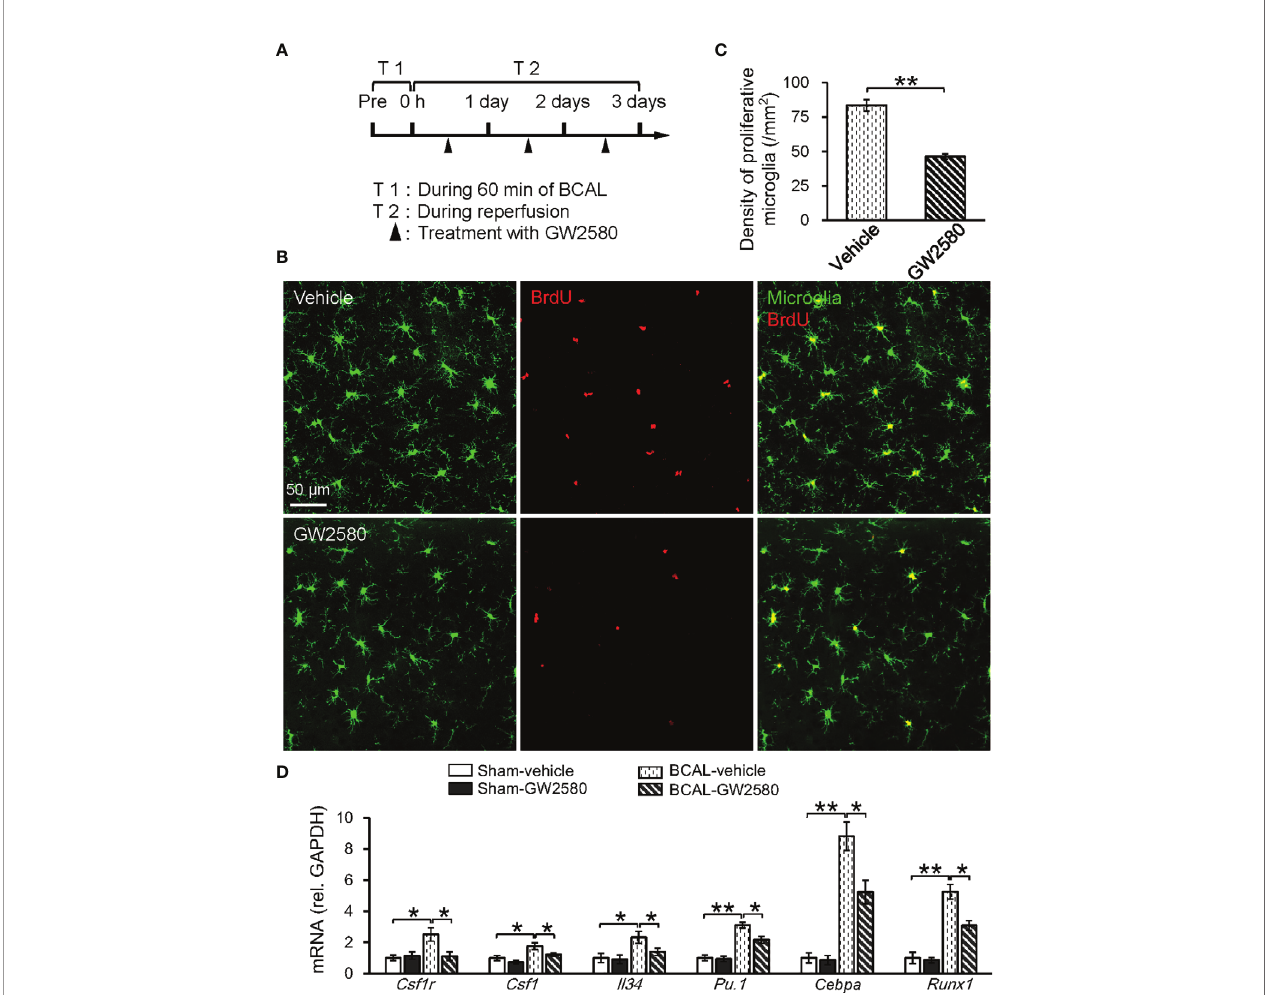
FIGURE 7 | Proliferation of microglia induced by 60 min ischemia was suppressed by CSF1R inhibitor GW2580. (A) Timeline showing ischemia, reperfusion and GW2580 treatment. Filled arrows show the timepoints of intragastric administration of GW2580. (B) Confocal images showing microglia (green) and BrdU labeled proliferative cells (red) in Vehicle and GW2580 group. (C) Quantitative data showing the densities of proliferative microglia in Vehicle and GW2580 groups. Note that GW2580 treatment signi fi cantly inhibited microglial proliferation induced by 60 min BCAL (n = 6 mice for each group; ** p <0.01). (D) qRT-PCR showing the effect of GW2580 treatment on the mRNA levels of CSF1-related genes. Note that the expressions of these genes showed no difference with or without GW2580 in Sham groups but were suppressed by GW2580 in ischemic groups (n = 4 mice for each group; * p <0.05, ** p